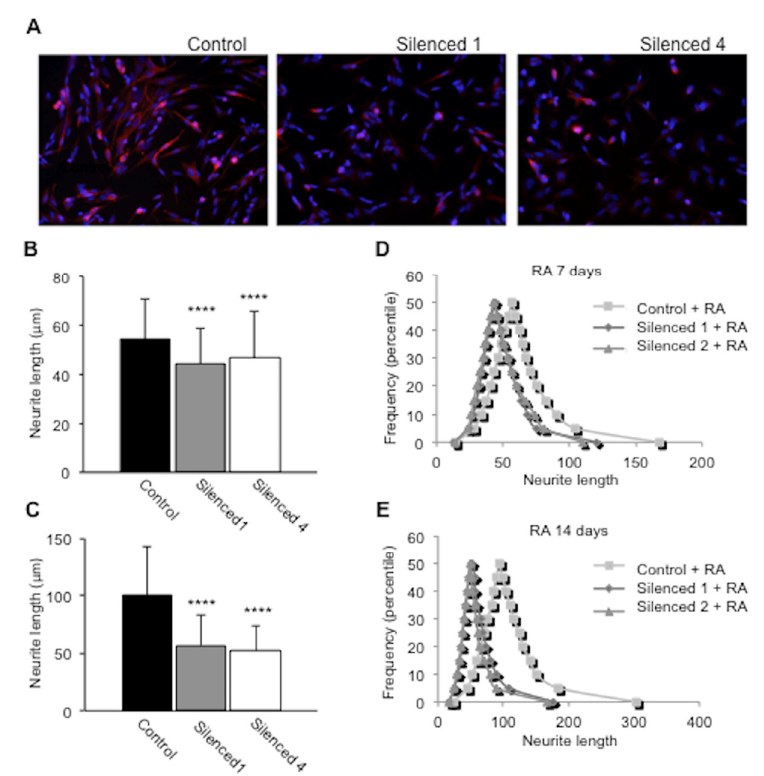
Figure 2. DISC1-silenced cells show morphological impairment in neurite outgrowth assays. Cells were treated with retinoic acid (RA) for 7 and 14 days and neurite length was measured using Image J. ( A ) Fluorescence images of SH-SY5Y cells expressing control and DISC1 shRNAs treated with RA for 7 days and immunostained for β III-tubulin (red); nuclei were stained using DAPI (blue). ( B , C ) Average neurite length ± SD; (**** p < 0.0001, significantly different between control and DISC1-silenced cells, n > 200 for each cell line). ( D , E ) Frequency (percentile) of cells according to neurite length at 7 days ( D ) and 14 days ( E ) for each cell population; p < 0.0001 control vs. silenced 1 at 7 and 14 days, p < 0.0001 control vs. silenced 4 at 7 days, p < 0.001 control vs. silenced 4 at 14 days (Mann–Whitney U test).